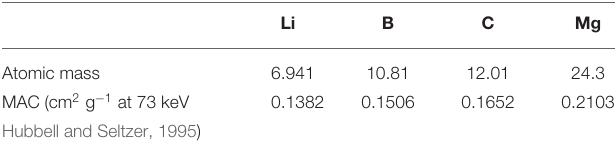
TABLE 1 | Basic elemental data. TABLE 2 | The calculated results for Li-Mg (solid solution) and other